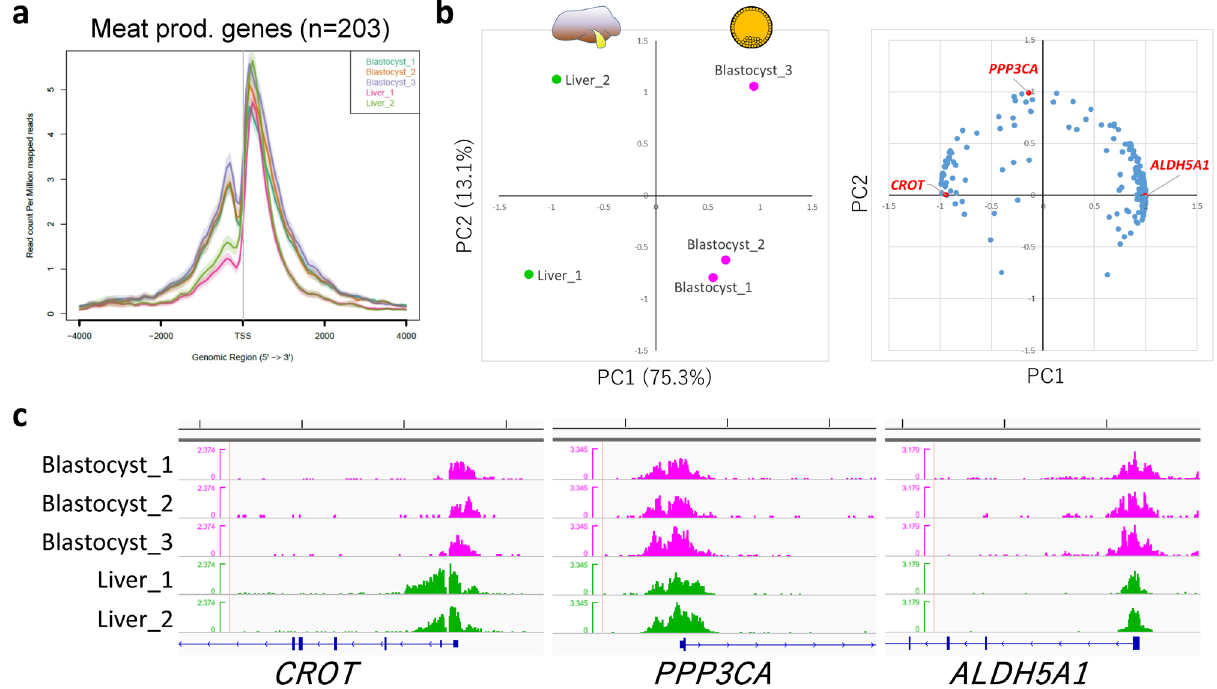
Figure 4. Characterization of H3K4me3 modifications common in blastocysts and liver in terms of meat production-related genes. ( a ) Average profile plot of the H3K4me3 signal around the TSSs of 203 meat production-related genes. ( b ) PCA of liver and blastocyst samples considering the peak areas around the TSSs of 203 meat production-related genes. Left and right panels show the principal component plot of all samples and loading plot of the 203 genes, respectively. The genes whose H3K4me3 landscapes are shown in ( c ) are highlighted in red. ( c ) H3K4me3 landscapes of CROT , PPP3CA , and ALDH5A1 around their TSSs. Five-kb graduations are shown in the top